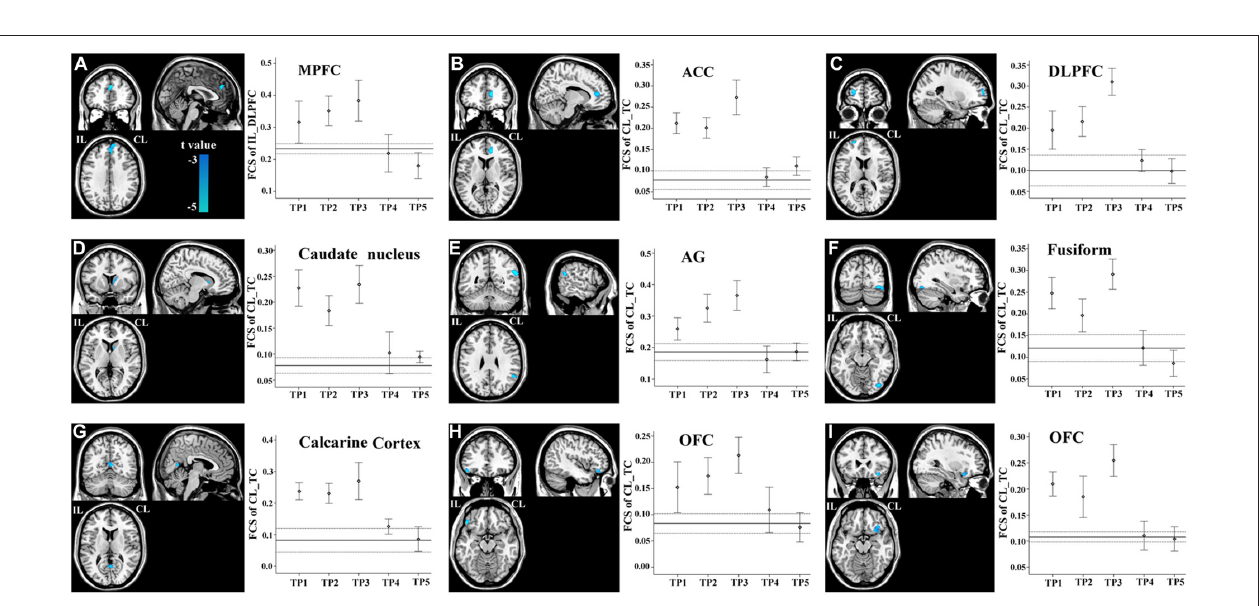
FIGURE 5 | Linear increase in FCS between the contralesional SMC and the ipsilesional SMC . The ipsilesional SMC (A) exhibit linear increases in FCS with the contralesional SMC. The solid and dashed lines (B) demonstrate the mean and standard error of the FCS in normal controls, respectively. Error bars illustrate the standard error. CL, contralesional; FCS, functional connectivity strength; IL, ipsilesional; SMC, sensorimotor cortex; TP, time points.